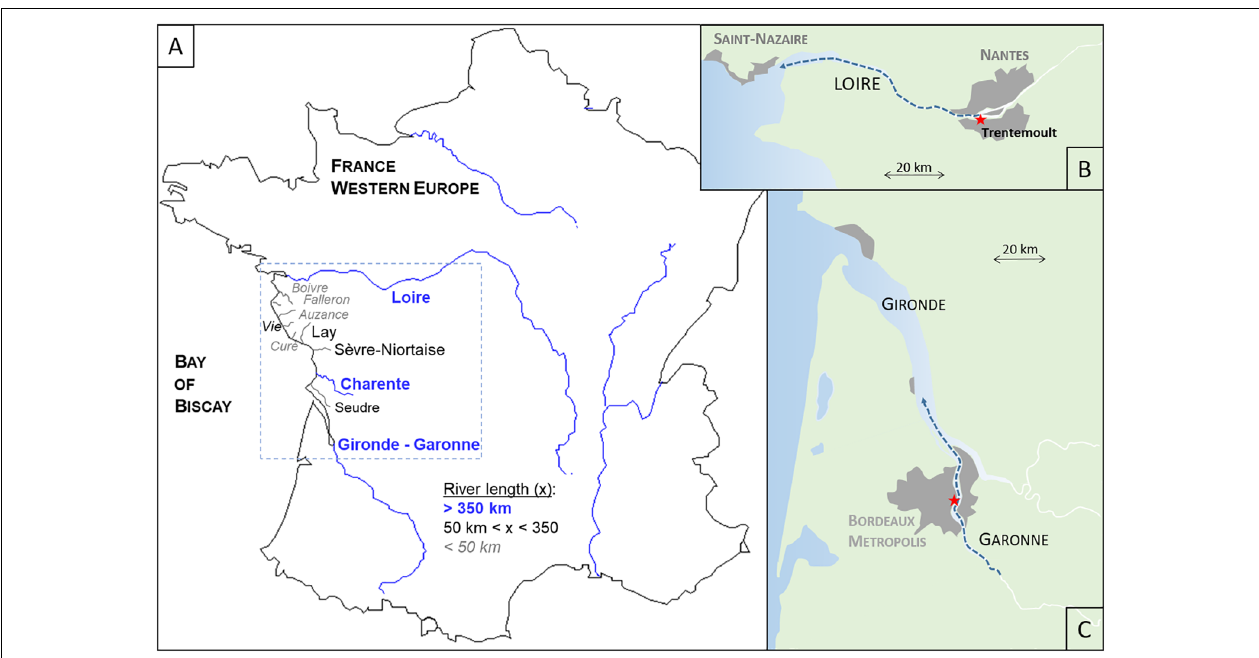
FIGURE 1 | (A) Estuaries facing the Bay of Biscay between the Loire and the Gironde. (B) The Loire estuary. (C) The Gironde estuary. Gray areas indicate the main cities. The range of the total river length ( x ) is given (the extension of the tidal section is not always defined for the small